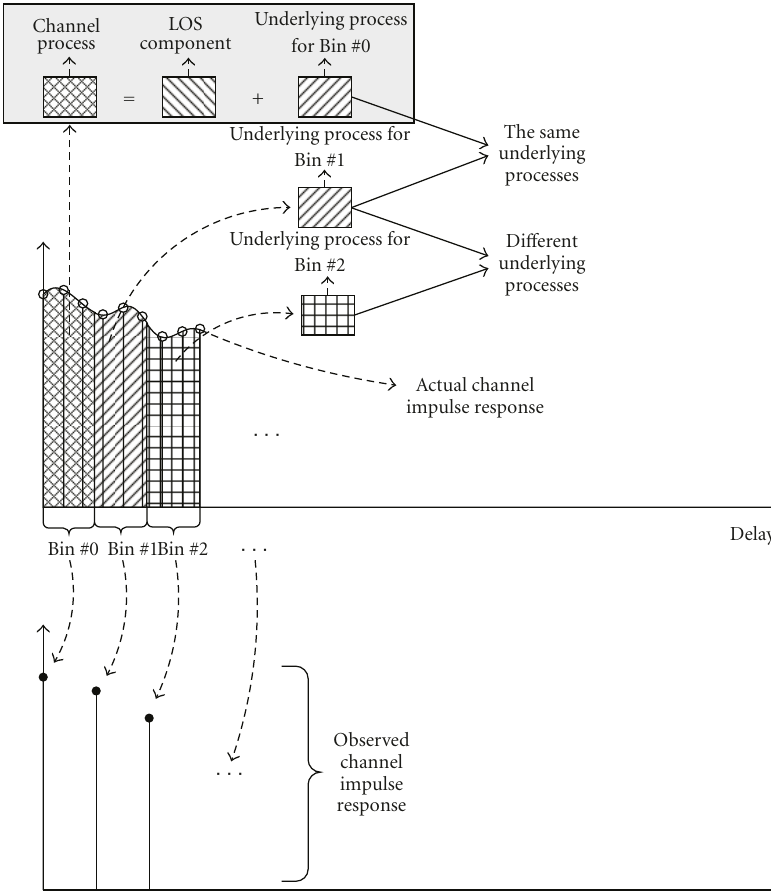
Figure 1: Illustration of the concept of “underlying process” and its relationship with channel impulse response. In this figure, first bin consists of two processes. One of them, which is referred to as “Underlying process for Bin (cid:2) 0,” is the same as the process of “Bin (cid:2) 1.” However, underlying processes for Bin (cid:2) 1 and (cid:2) 2 are not the